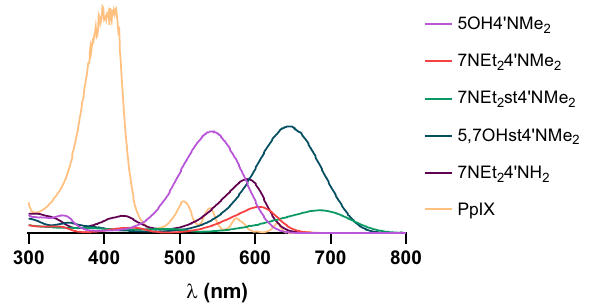
Figure 2. UV–Vis absorption spectra of the different synthetized amino-based flavylium compounds determined at pH 5.5 in 1% DMSO.